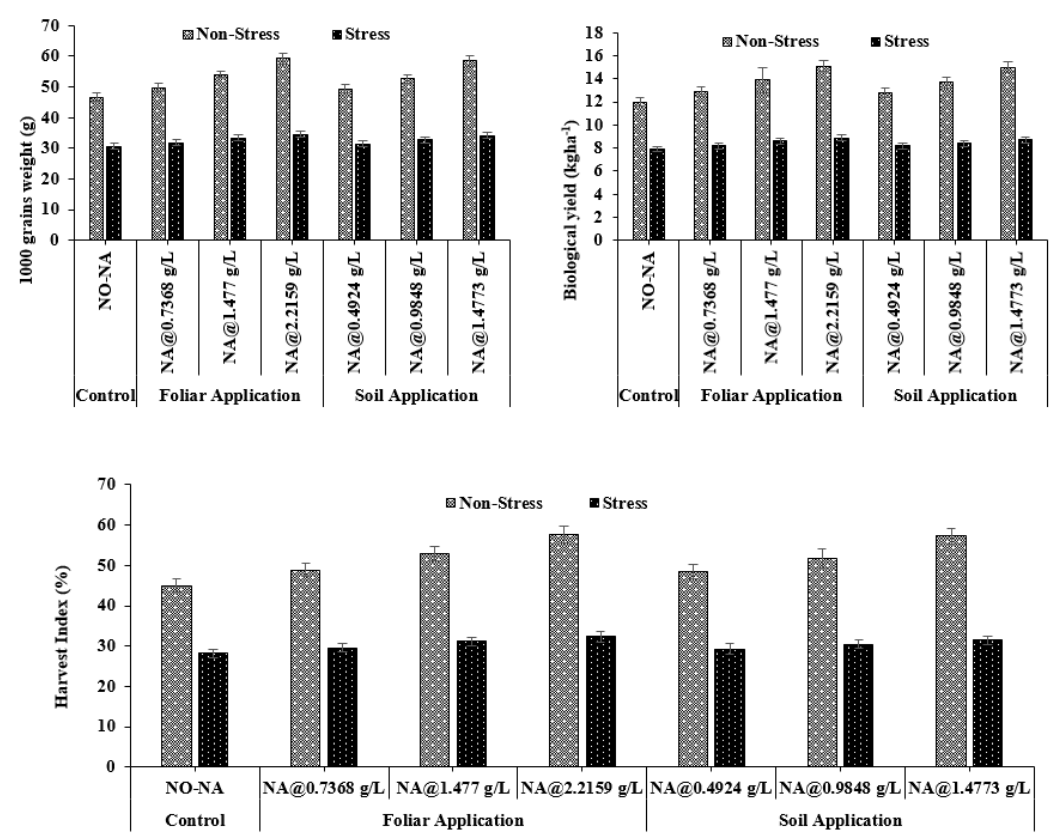
Figure 7. Effect of exogenously applied nicotinic acid on thousand-grain weight (g), grain yield (Kg ha − 1 ), and harvest index at anthesis stage of plant under control and water deficit stress levels.